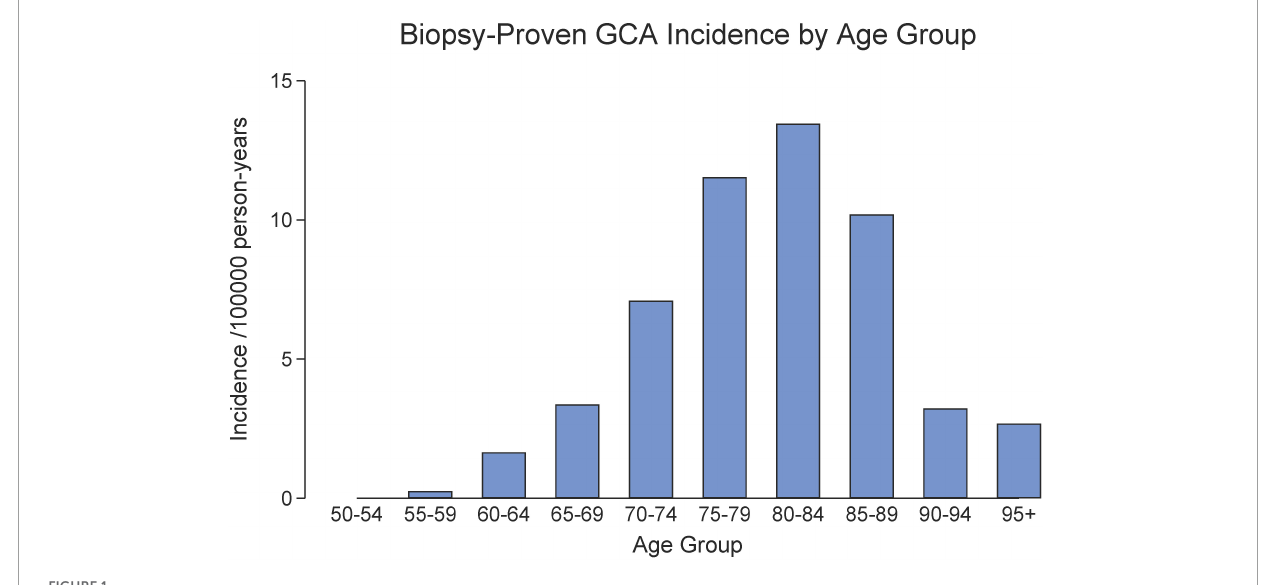
FIGURE1 Age distribution of biopsy-proven GCA in South Australia (2014–2020).